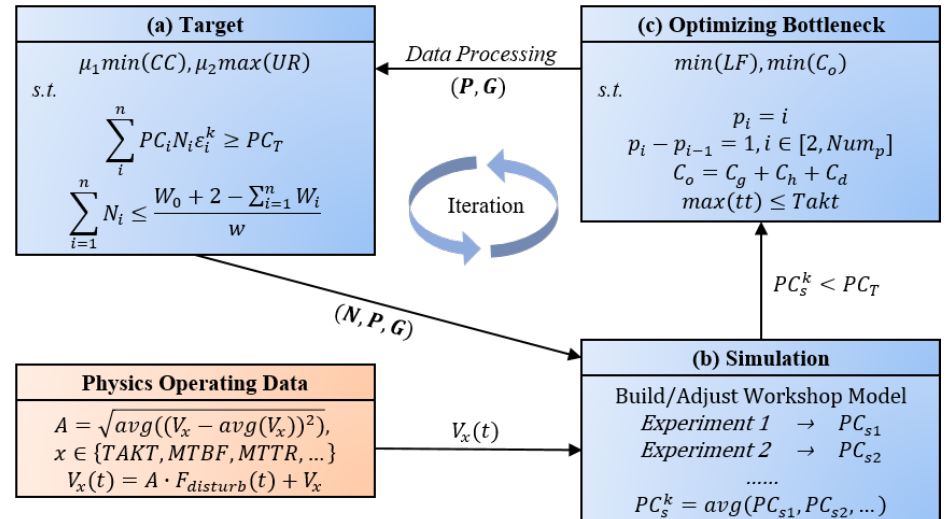
Figure 9. The iterative calculation process. ( a ) The calculation process of related parameters of each type of production line. ( b ) The process of simulating multiple times. ( c ) The calculation process of bottleneck